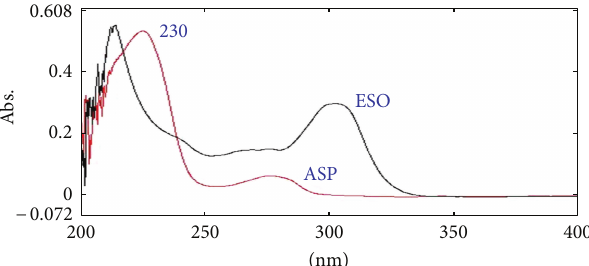
F 3: Chromatogram of mixed standard solution containing